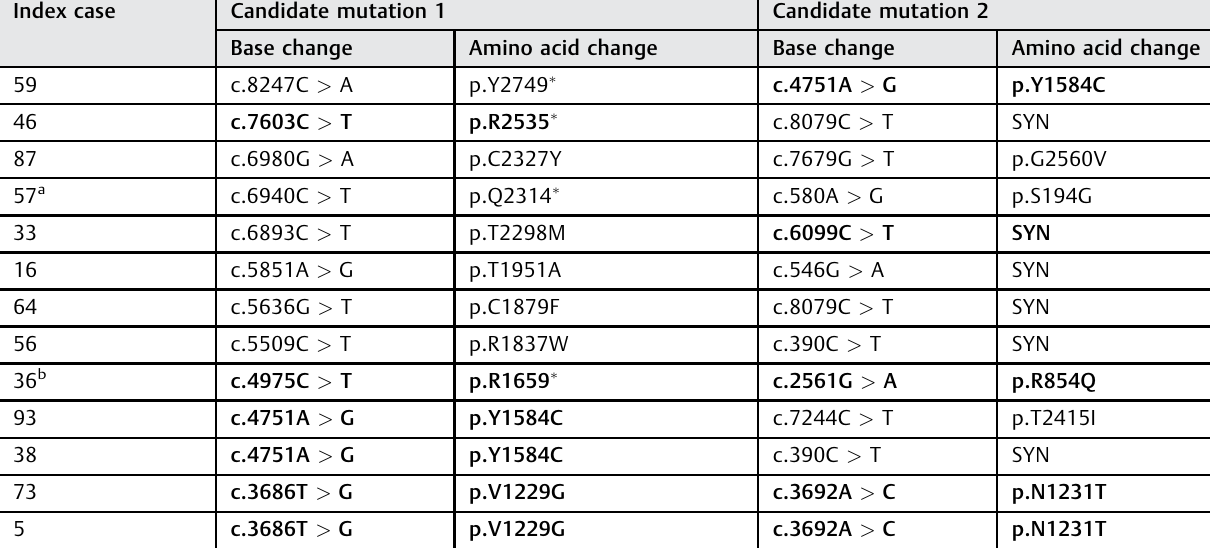
Table 3 Index cases with two or three candidate mutations/variants